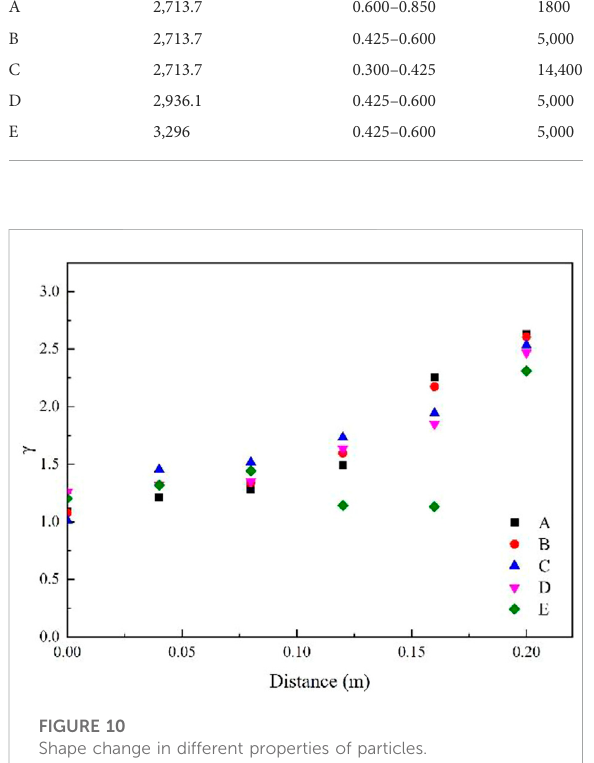
FIGURE 10 Shape change in different properties of particles.